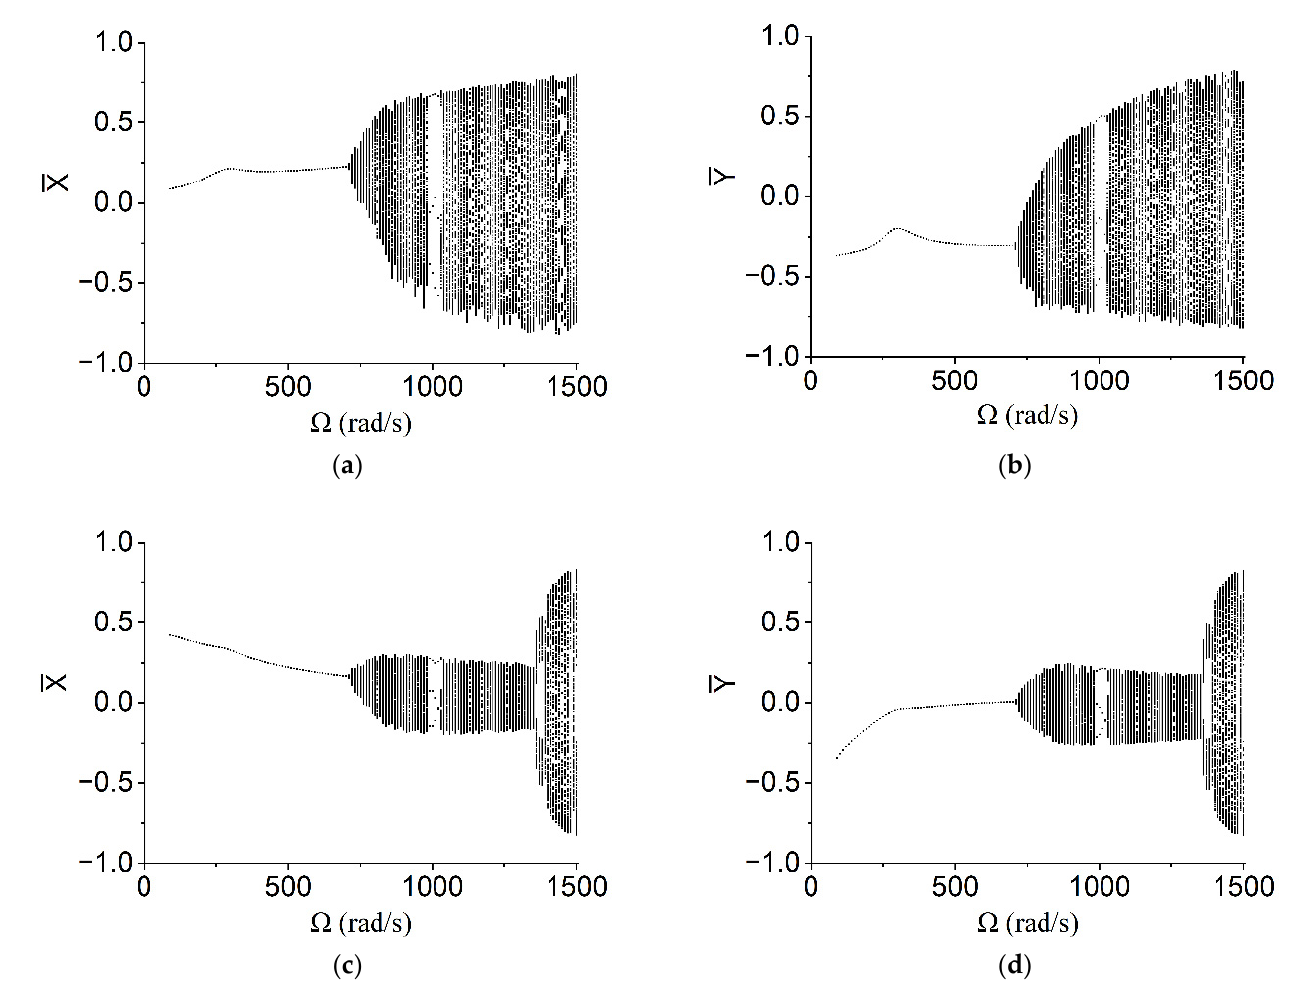
Figure 11. The bifurcation maps of Y-displacements of the traditional method: ( a ) X-displacement of rotor; ( b ) Y-displacement of rotor; ( c ) X-displacement of bearing; ( d ) Y-displacement of bearing.